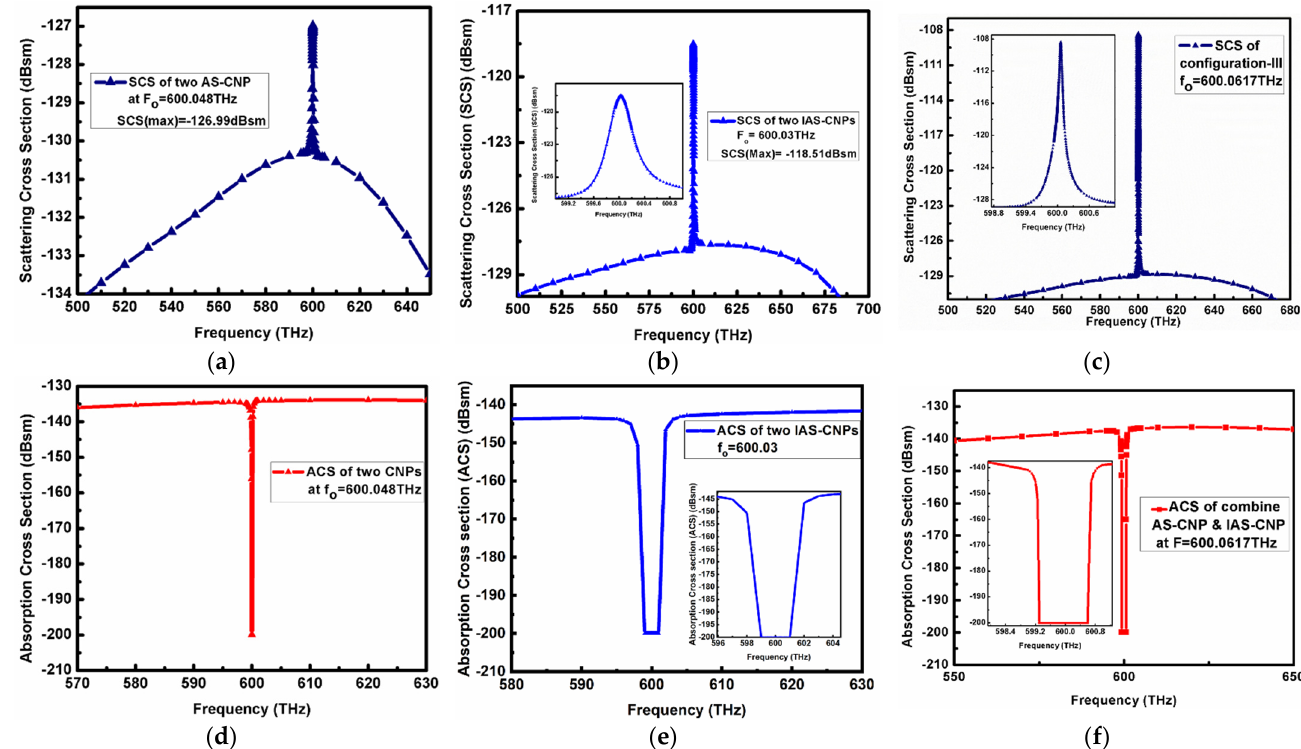
Figure 4. ( a ) Optimized SCS peaks for configuration I, ( b ) SCS peak for configuration II, ( c ) SCS peak for configuration III, ( d ) ACS for configuration I, ( e ) ACS for II and ( f ) ACS for configuration III at resonance frequency.